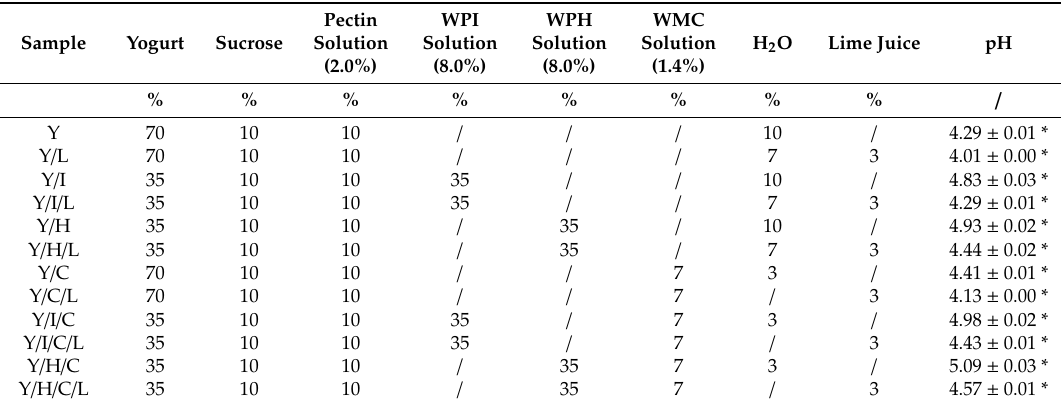
Table 1. Formulation and pH of yogurt